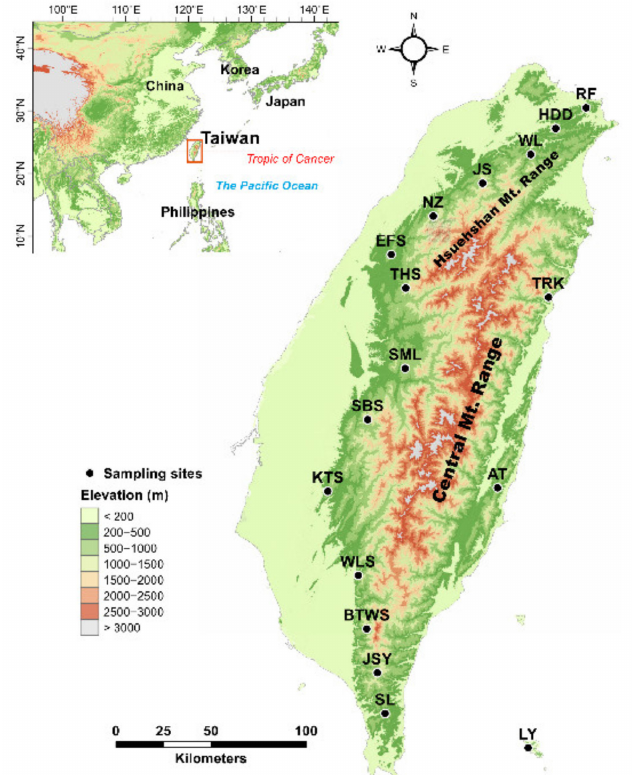
Figure 1. Sampling localities of the 17 Zingiber kawagoii populations. The coordinates of sampling sites were used to plot population locations using Tools in ArcGIS v.10.8.1. Map was derived from the default map database in ArcGIS, and the 20 m digital elevation model was used in the generation of elevation gradients. See Table 1 for abbreviations of the population